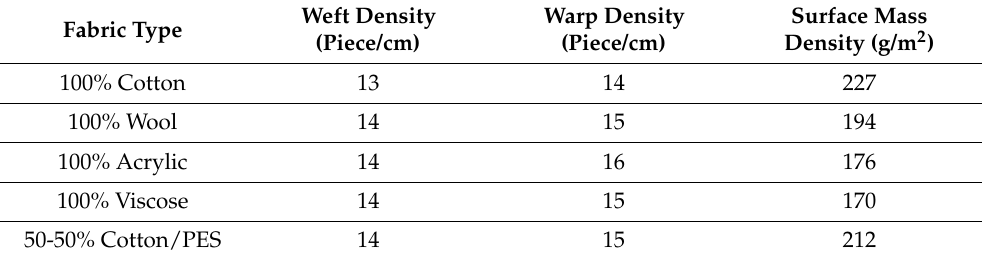
Table 1. Weaving density and weight density values of the yarns employed for samples realization. Weft Density Fabric Type (Piece/cm)